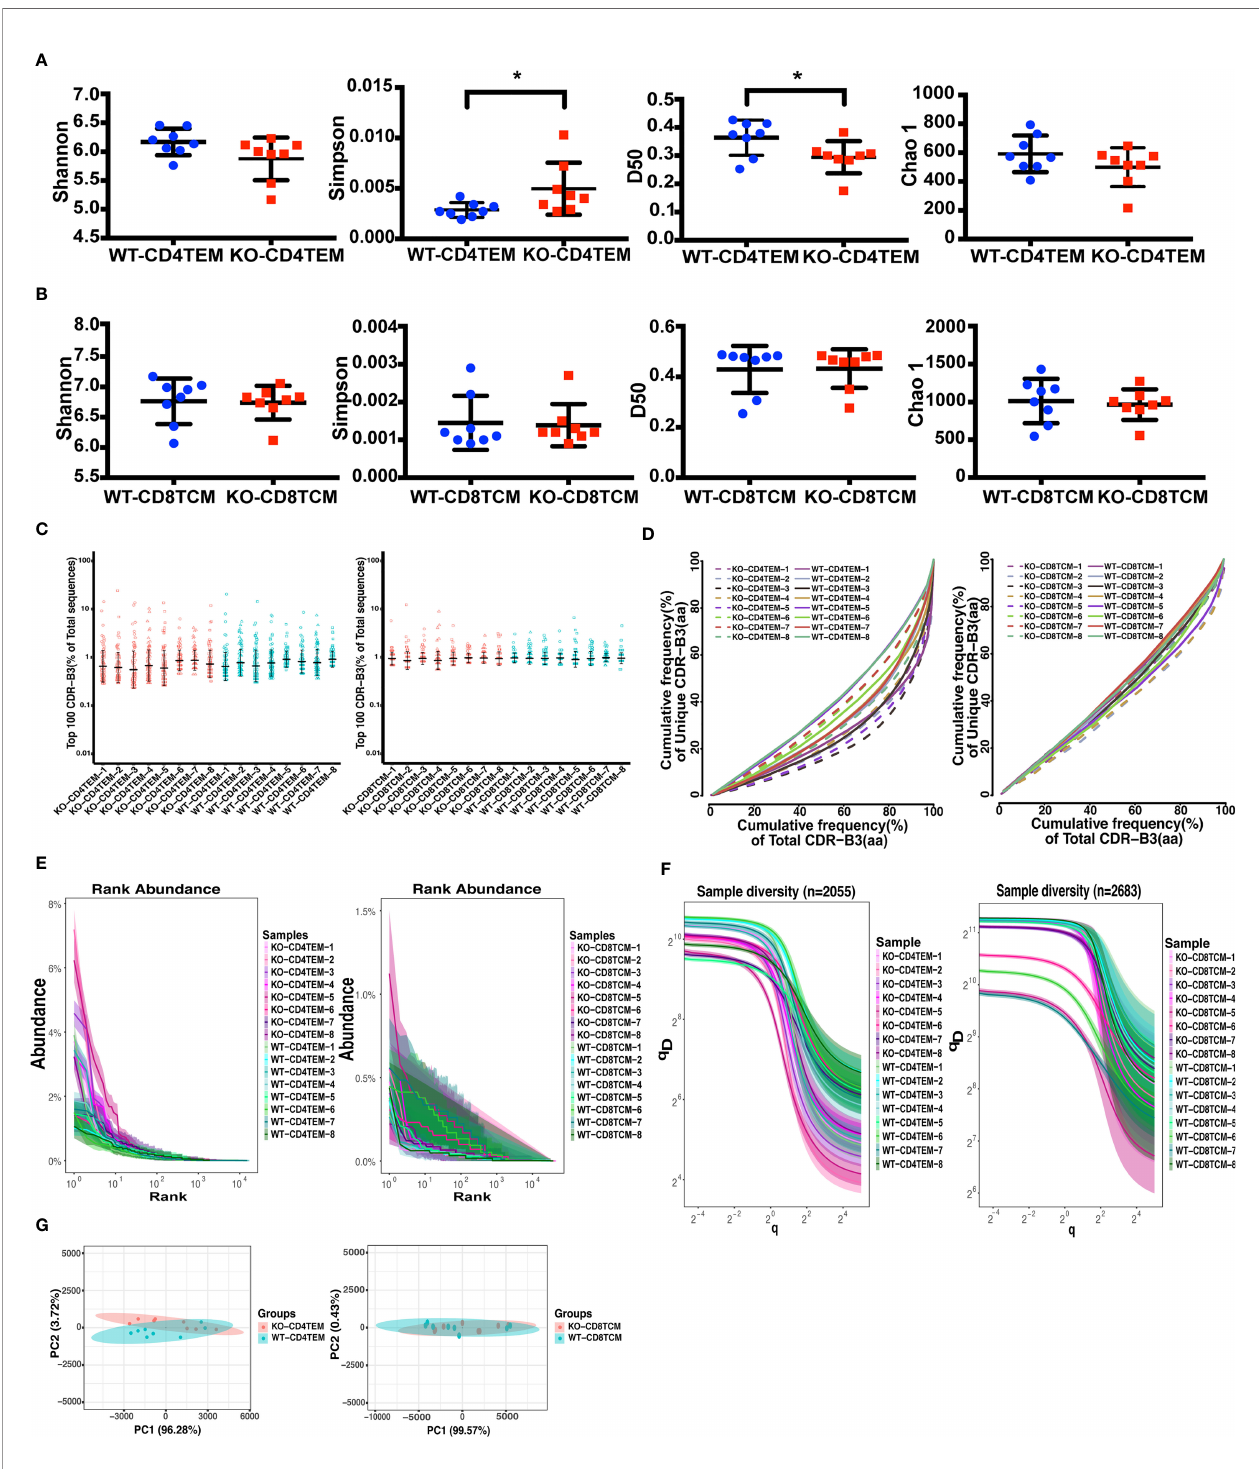
FIGURE 1 | Diversity and clonality analysis of TCRV b repertoires of CD4 + TEM cells and CD8 + TCM cells in WT and KO chimeras. Quanti fi cation of the diversity, unevenness, clonotypic expansion, and richness of TCRV b repertoires using the Shannon – Wiener index, Simpson index, D50, and Chao 1 index in CD4 + TEM cells (A) or CD8 + TCM cells (B) . Representation of the frequency of the top 100 most abundant clones for TRB sequences (C) . The cumulative frequencies of unique versus total CDR3 clonotypes are shown for TCR b repertoires (D) . Mean values ± SE are shown; t-test was used for statistical analysis, *p <0.05. Showing is the Rank-abundance curve and sample diversity curve by using the abundance of total TRB sequences versus TRB sequences Rank (E) and true diversity ( q D) versus q (F) . Sample plots illustrating the segregation of the various KO from WT chimeras based on primary component (PC) 1 and 2 determined by four variables (Shannon – Wiener index, Simpson, number of total and unique sequences) for TCRV b repertoires (G)